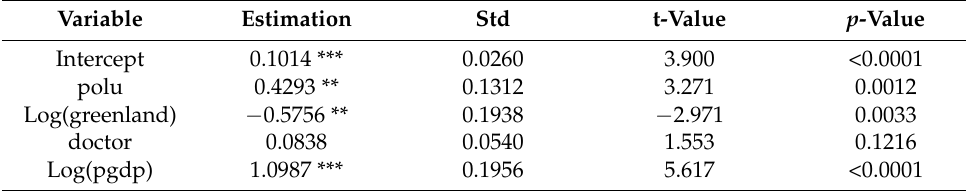
Table 4. The linear effect result of environmental status on mortality. Variable